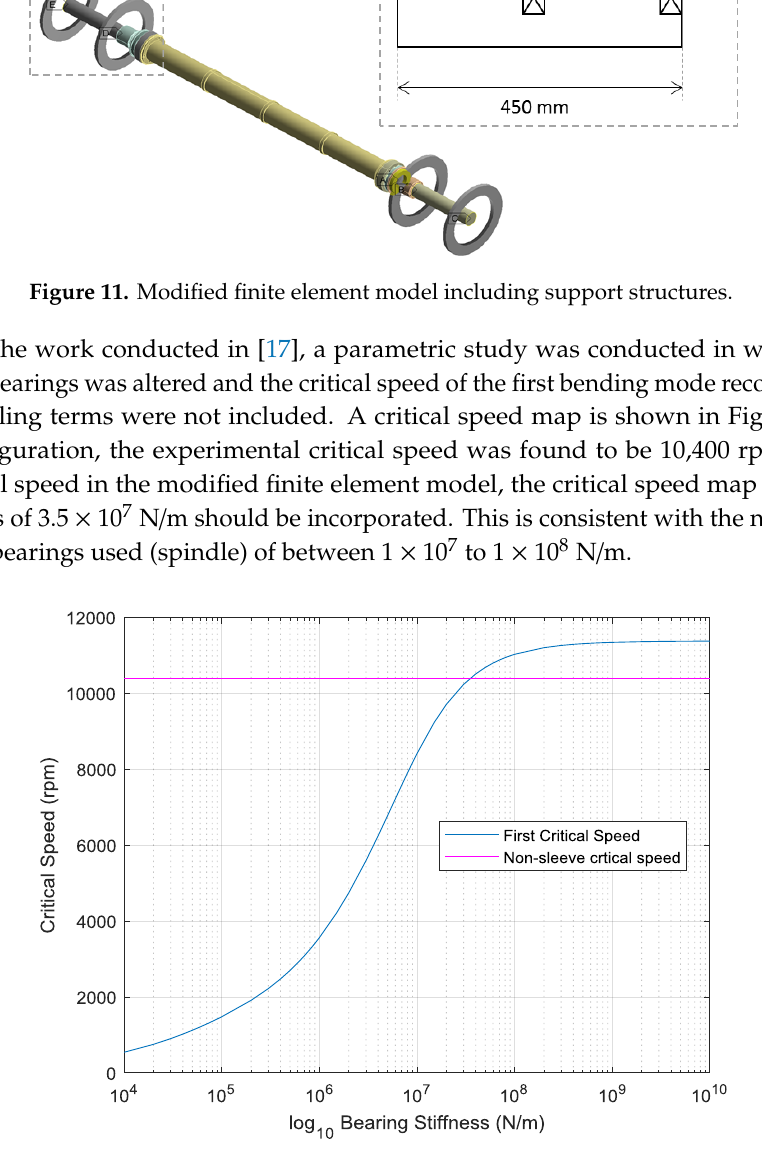
Figure 12. Critical speed map for first bending mode for no-sleeve configuration.